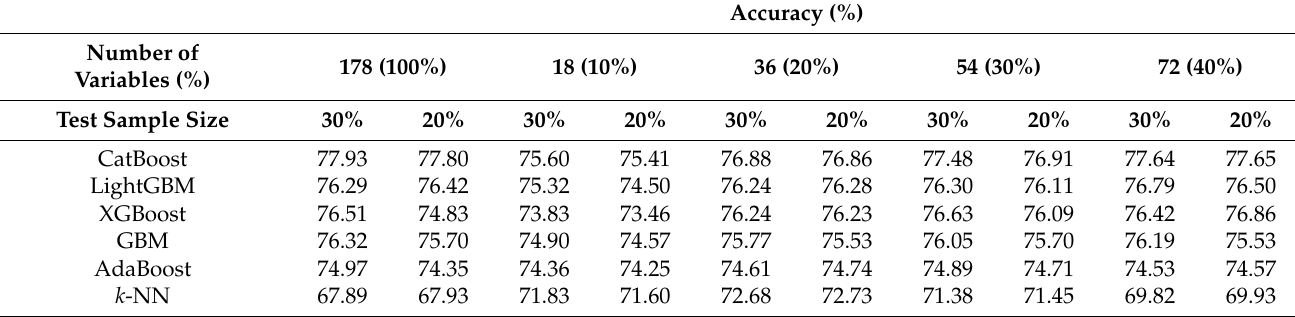
Table 3. Classification accuracy for the DMI